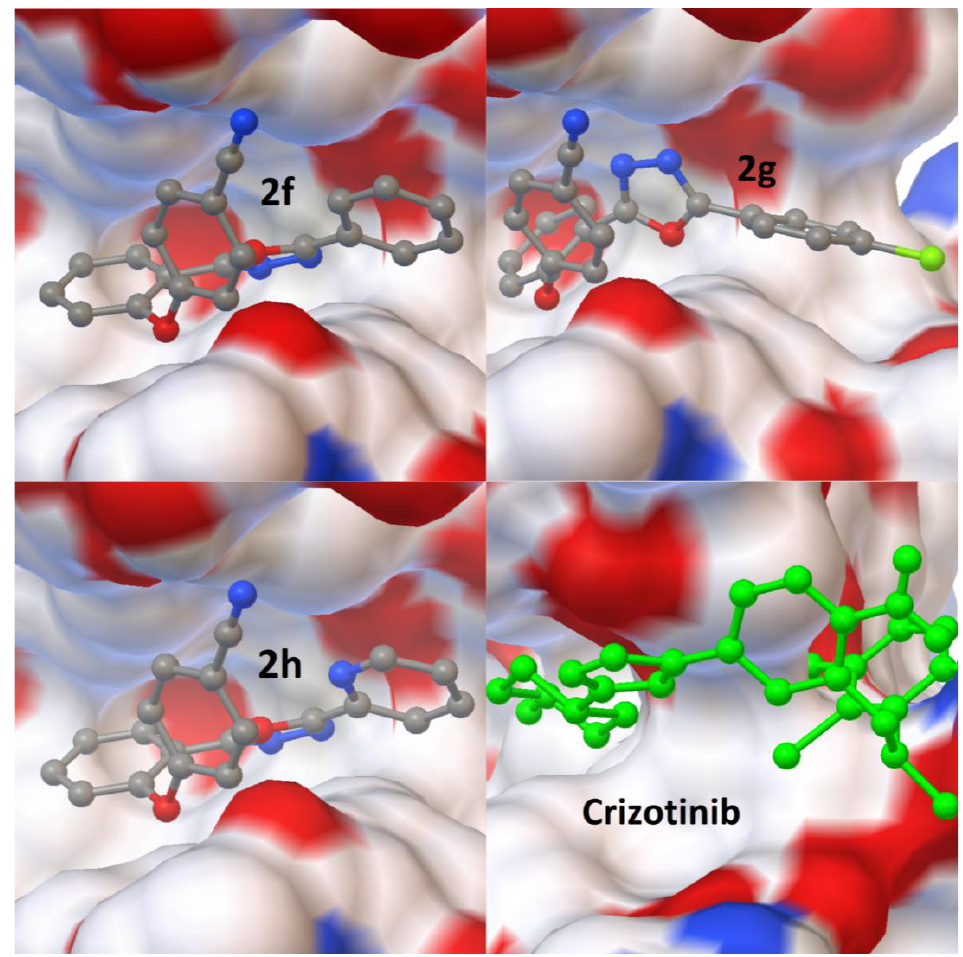
Figure 8. Interaction of the best-docked poses of compounds 4f , 4g , 4h and reference drug crizotinib to 2XP2 target.